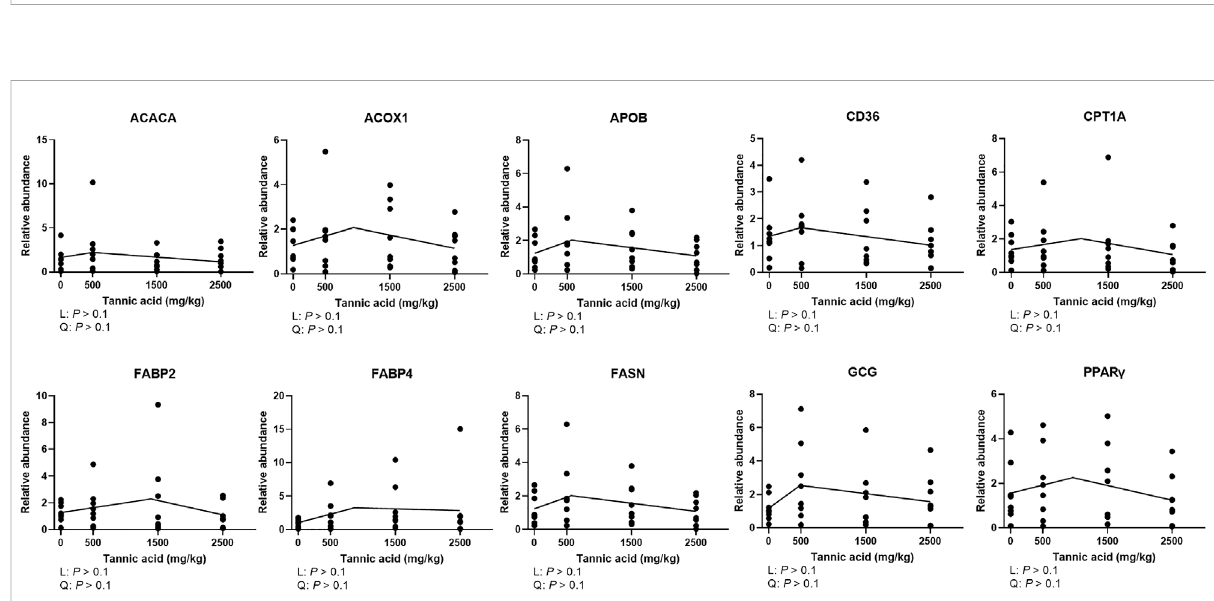
FIGURE 8 Relative mRNA expression of genes related to fat metabolism in the liver of broiler chickens fed different concentrations (0, 0.5, 1.5, and 2.5 g/kg) of tannic acid on D 21. The treatment groups were compared using one-way ANOVA followed by the Tukey ’ s multiple comparison. Different superscripts differ at p < 0.05. Orthogonal polynomial contrasts analysis was conducted to see linear pattern (L) and quadratic pattern (Q) among the treatments. To calculate the optimal dosage of tannic acid in broilers, segmented linear regression was conducted, and X0 (in fl ection point) with p values for slope 1 (lower than X0 ) and slope 2 (higher than X0 ) were presented. ACACA, acetyl-CoA carboxylase alpha; ACOX1, acyl-CoA oxidase 1; APOB, apolipoportine B; CD36, clusters of differentiation 36; CPT1A, carnitine palmitoyltransferase 1A; FABP, fatty acid binding protein; FASN, fatty acid synthase; GCG, glucacon; PPAR γ , peroxisome proliferator-activated receptor